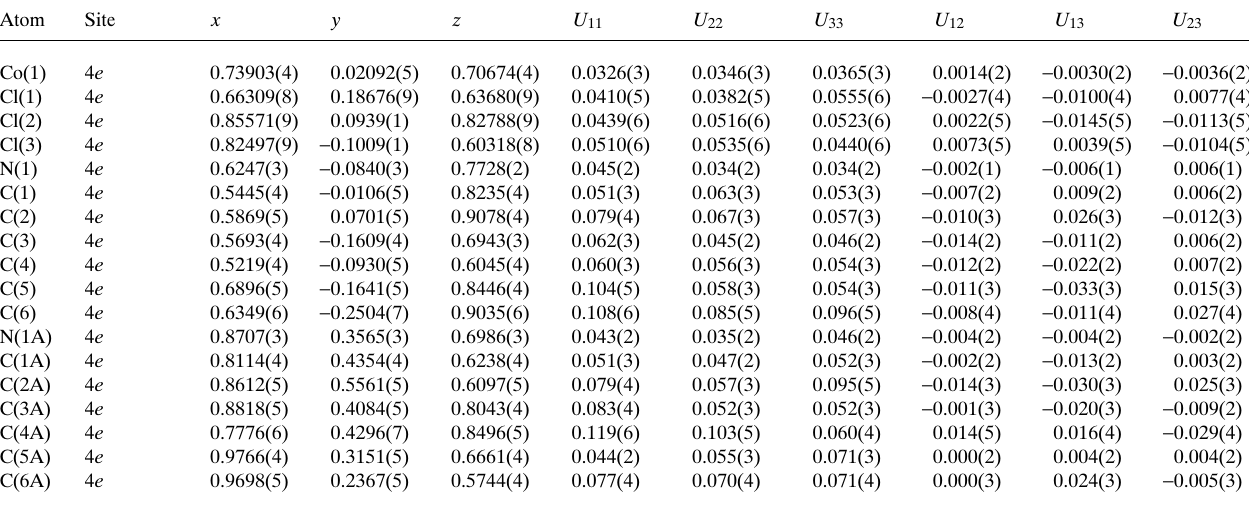
Table 3. Atomic coordinates and displacement parameters (in Å 2 ) .